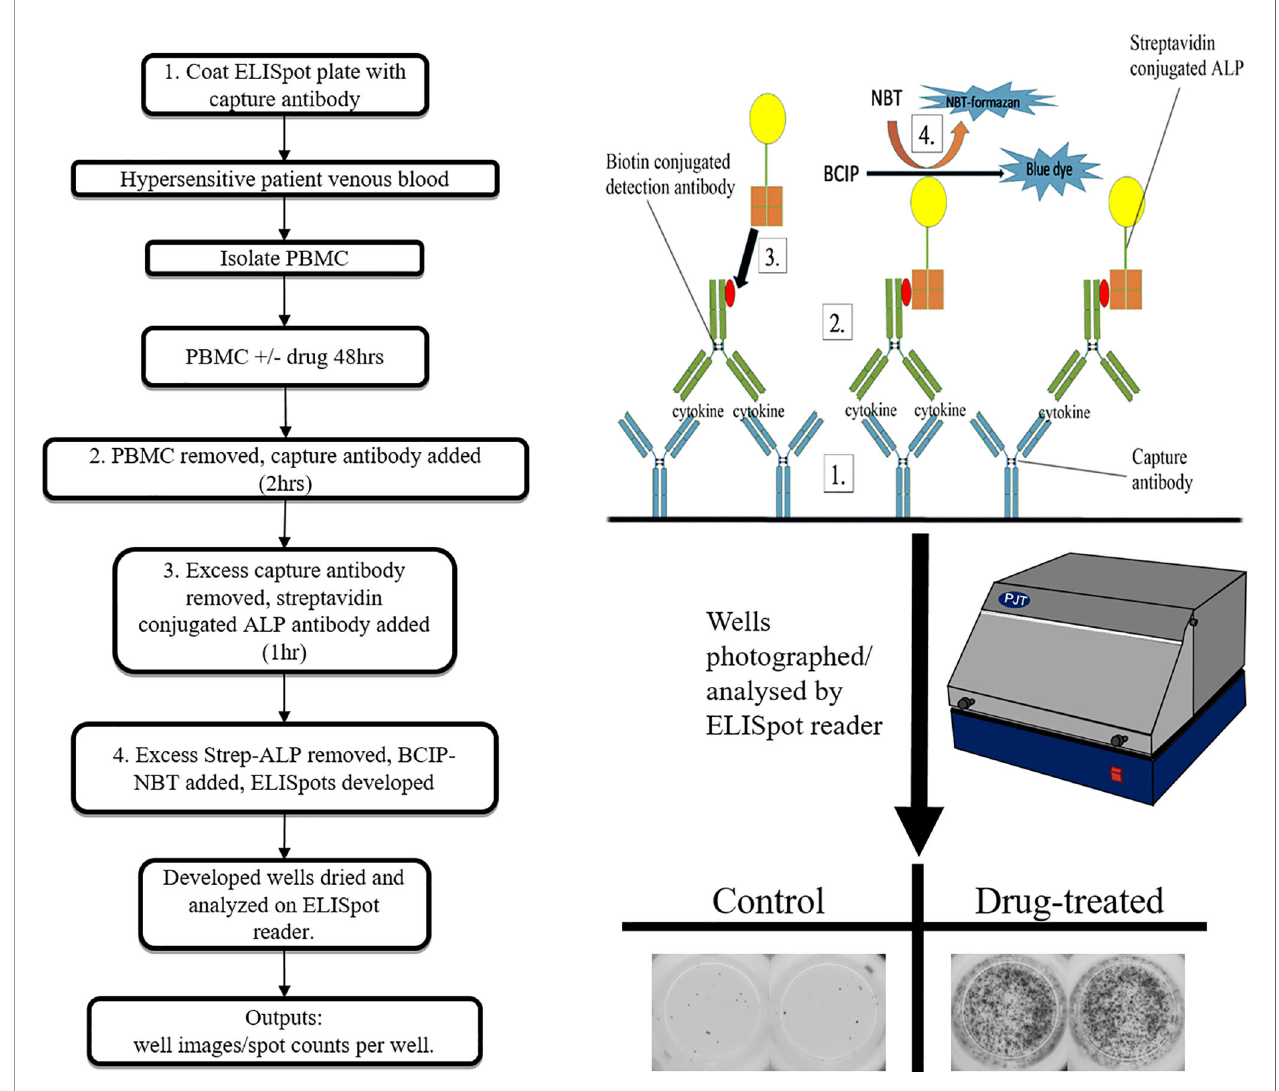
FIGURE 4 | Overview of enzyme-linked immunospot (ELISpot)